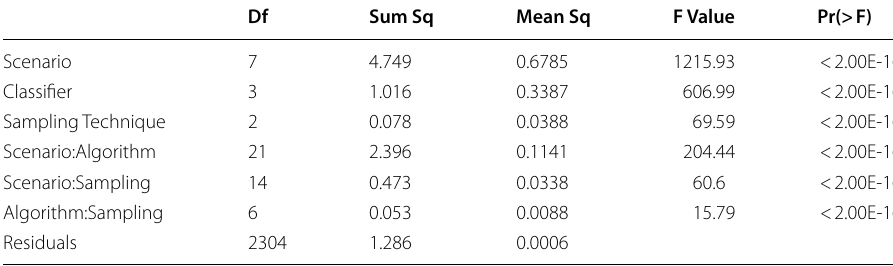
Table 11 Three-factor ANOVA for